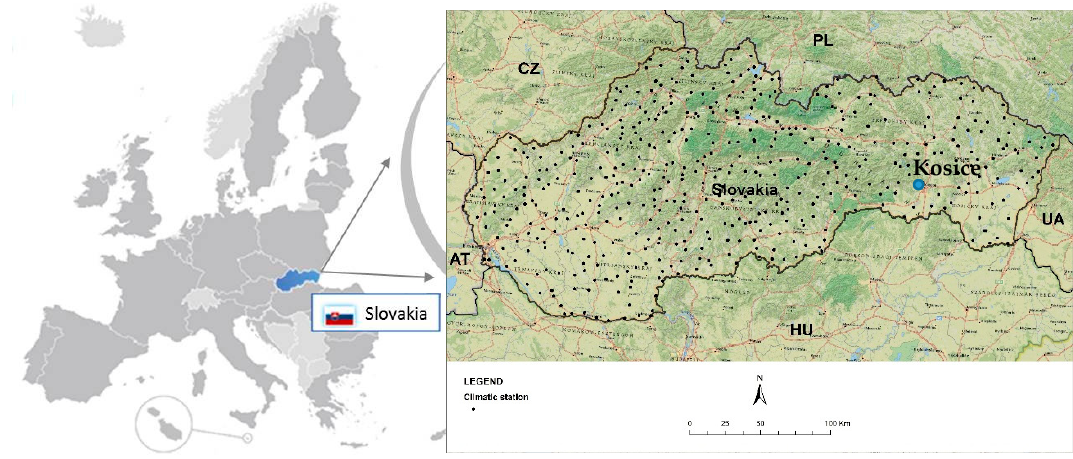
Figure 1. Study area—Košice City.